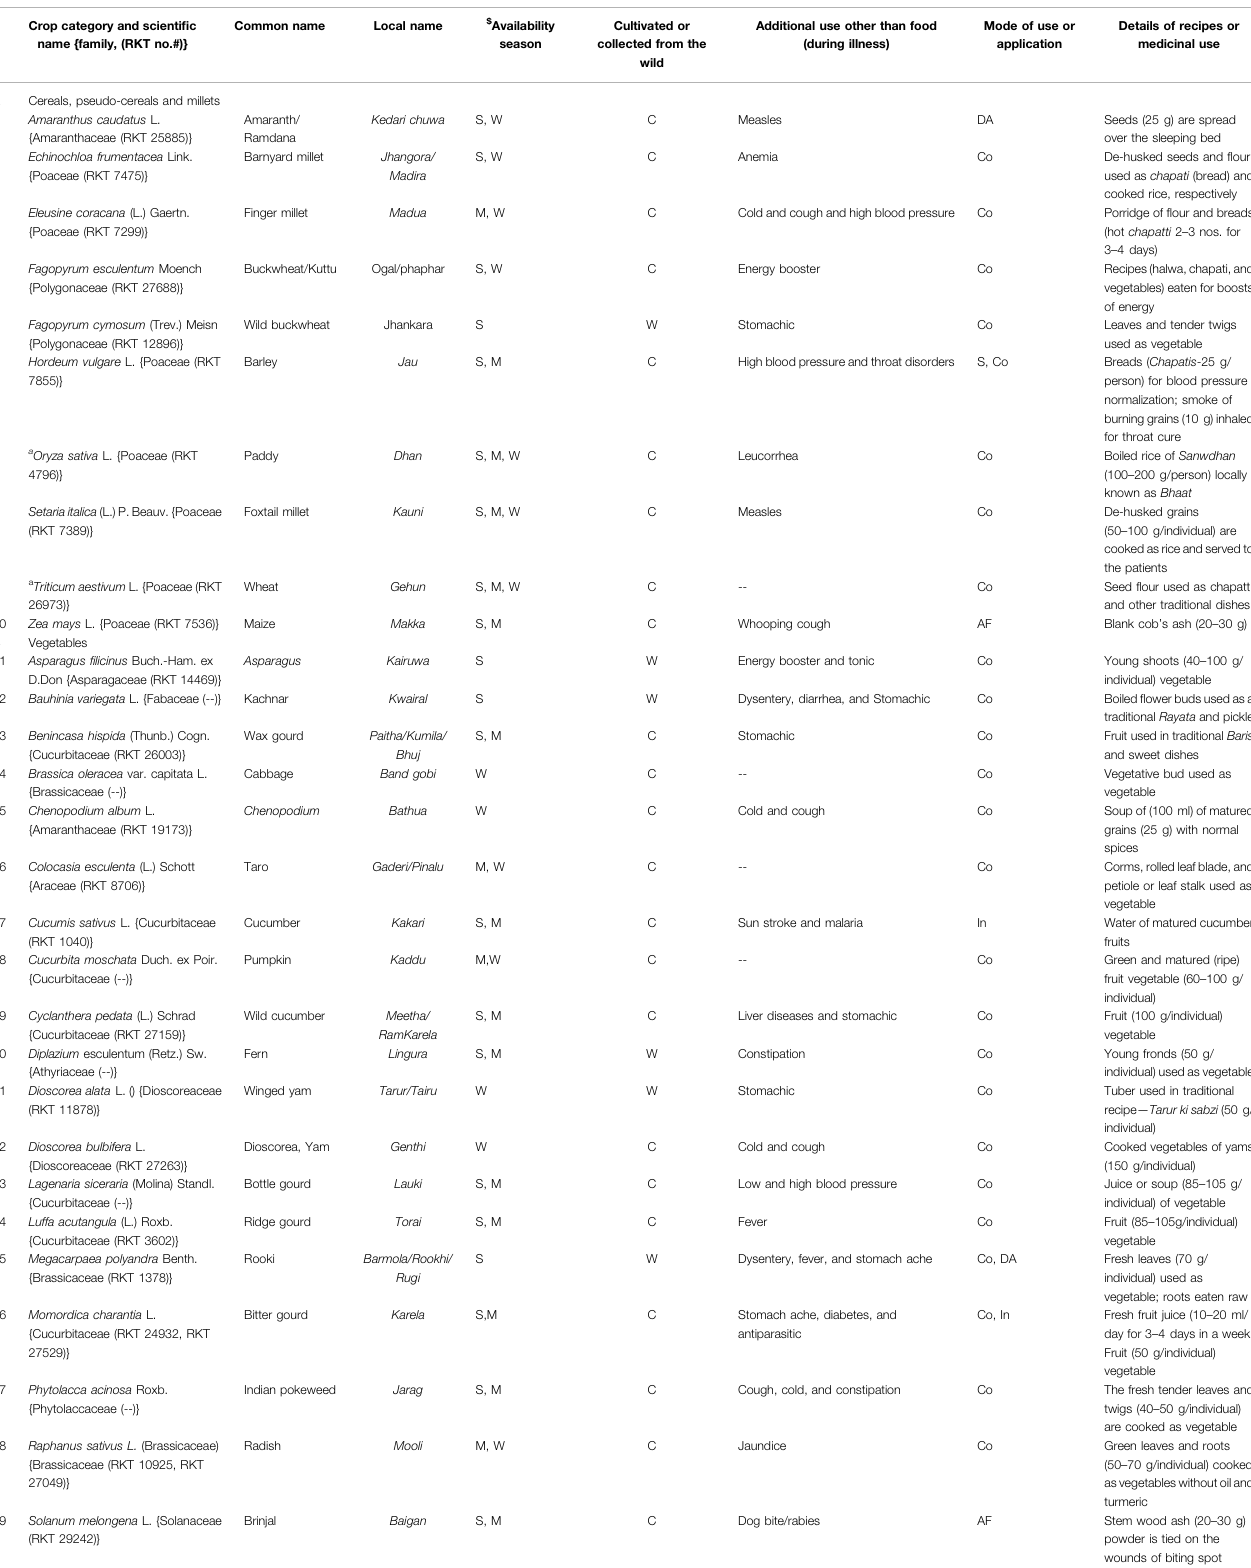
TABLE 1 | Crops plants used as traditional foods, nutritional security, and primary healthcare by central Himalayan communities. Cropcategory and scienti fi c name {family, (RKT no.#)}